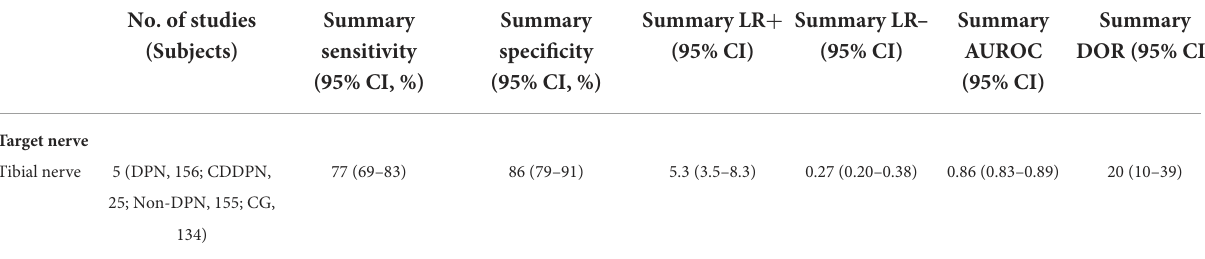
TABLE 5 Meta-analysis results of the stiffness of the tibial nerve using 2D-SWE for prediction of DPN. No. of